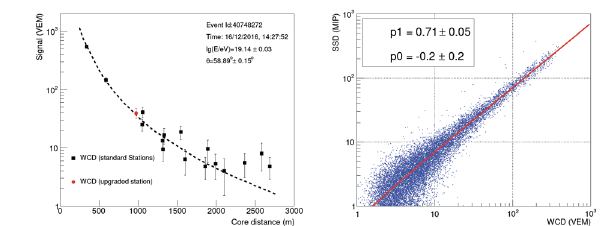
Figure 10. Left: the layout of the Surface Scintillator Detector (SSD). Right: One station of the AugerPrime Engineering Array. Figure 11. Left: one event reconstructed with the regular 1500 m